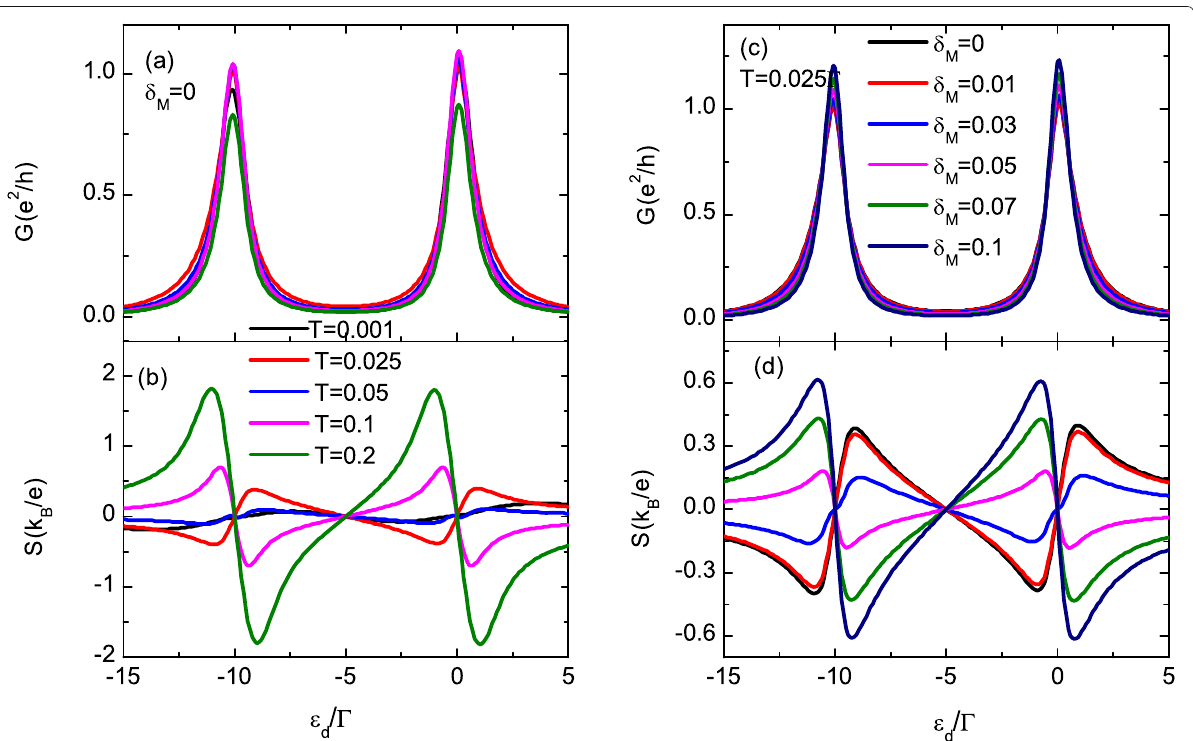
Fig. 3 Conductance and thermopower (color online). Counter plot of total conductance G and thermopower S as functions of ε d and (cid:10) M in a , b , temperature T in c , d , respectively. The value of λ 1 is fixed as 0.2 (cid:6) . The temperature in a , c is 0.025 (cid:6) , and in c , d (cid:10) M = 0. Other parameters are the same as those of Fig.